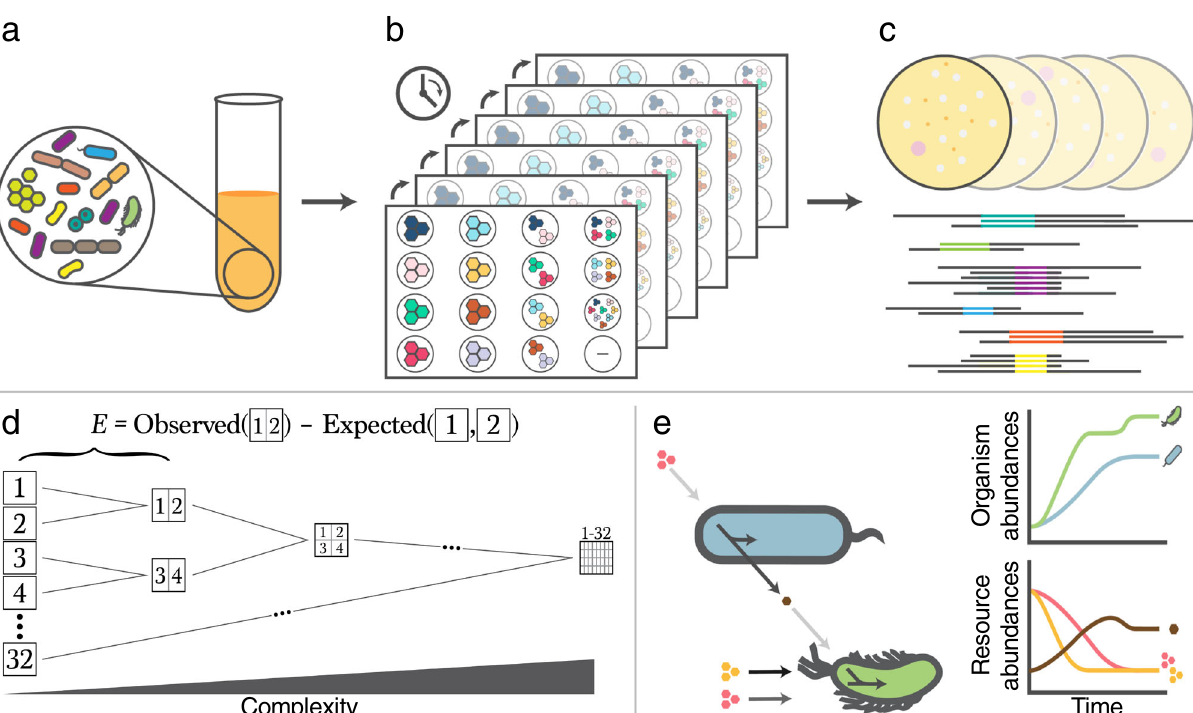
Fig. 1 Experimental schematic for testing microbial community responses to environmental complexity. a Communities were assembled by combining a de fi ned number of organisms (Supplementary Fig. 1a, Supplementary Table 1) at equal ratios. b These mixed cultures were then inoculated into deep-well plates containing a minimal medium plus equimolar combinations of up to 32 carbon sources (Supplementary Fig. 1b, Supplementary Table 2, Supplementary Table 3, Supplementary Table 4). The communities were either grown in batch or diluted into fresh media over the course of several days (Supplementary Table 5). c Growth yields were then assessed using a spectrophotometer and composition was determined using either agar plating or 16S sequencing. d Experiments were designed such that community phenotypes in more complex environments could be directly compared to simpler environments containing the same carbon sources. Measurements of simpler environments were used to generate expectations of phenotypes in more complex compositions. e Schematic of consumer resource modeling framework. Resources (pink and yellow) are utilized by organisms to generate biomass and secreted byproducts (see Methods). In this example, the bottom green organism is able to utilize both resources more ef fi ciently than the top blue one as denoted in the shades of the resource-organism arrows. The blue organism converts the pink resource into a brown metabolite, which can be utilized by the green organism for growth.